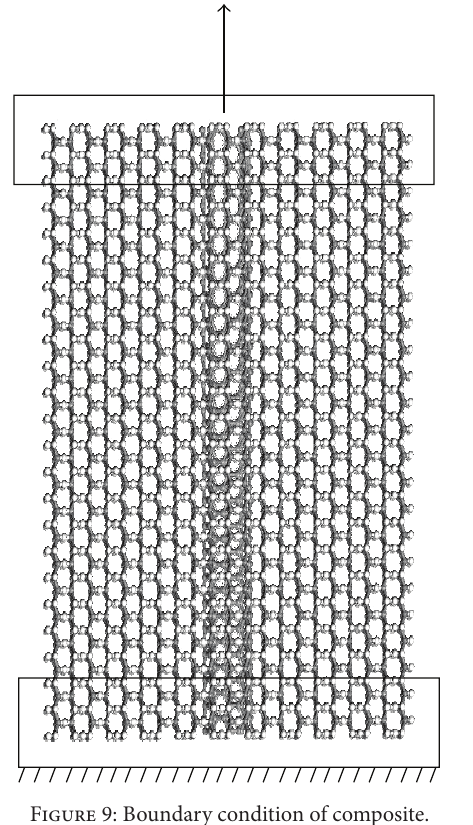
Figure 9: Boundary condition of composite.